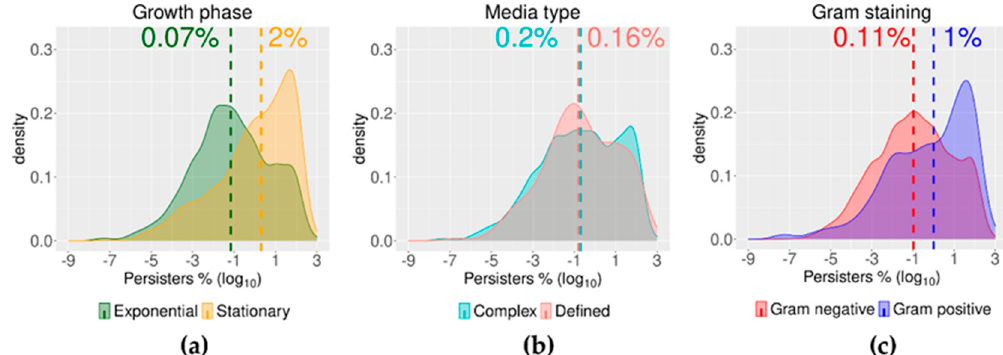
Figure 6. Data distribution for growth phase, media type, and Gram staining. ( a ) Growth phase: the data were clustered according to the growth phase of the cultures used for the persister assays. The abscissa represents the density distribution of the percentage of persister cells. The median of the persisters was 0.07% for cells from cultures in exponential growth phase and 2% for cells in stationary phase; ( b ) Media type: the data were clustered according to the media (either complex or defined media) of the cell cultures used for the challenge with antibiotics. The abscissa represents the density distribution of the percentage of persister cells. The median of the persisters was 0.2% for cells growing in complex media and 0.16% for cells growing in defined media; ( c ) Gram staining: the data as clustered according to the Gram-staining properties of all bacteria species. The abscissa represents the density distribution of the percentage of persister cells. The median of the persisters was 0.11% for cells from Gram-negative species and 1% for cells from Gram-positive species.